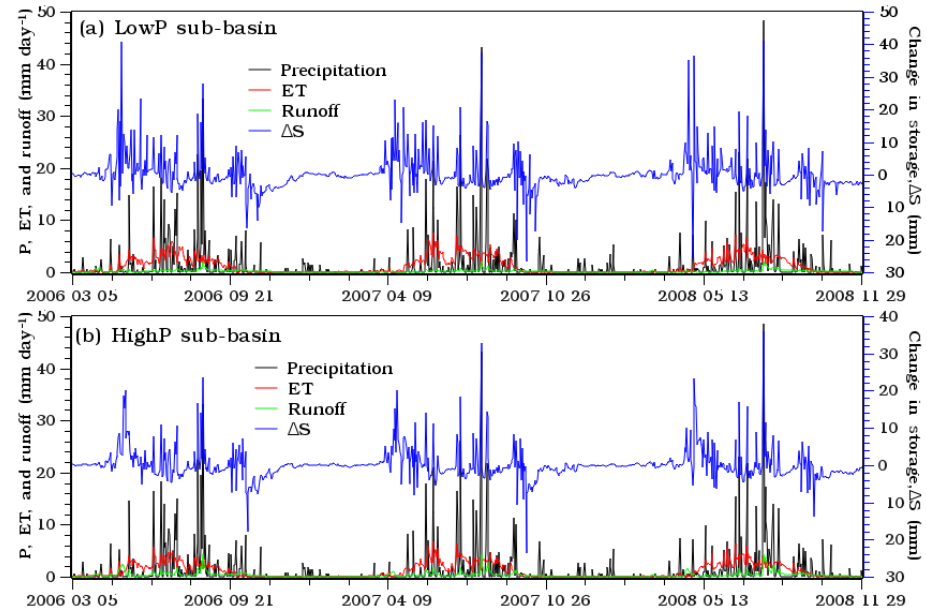
Figure 8. Partitioning of precipitation or snowmelt ( P , precipitation) into evapotranspiration (ET), runoff, and change in soil moisture storage ( (cid:49)S ) in the (a) LowP and (b) HighP sub-basins. All simulations are under aspect